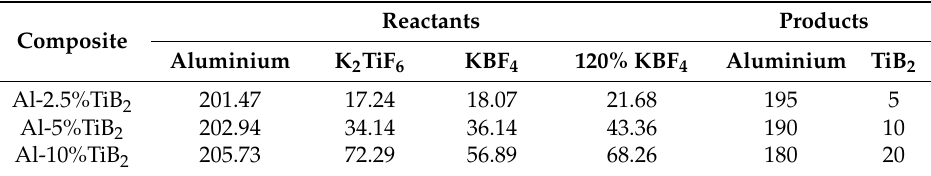
Table 1. Mass balance calculation to obtain 200 g of TiB 2